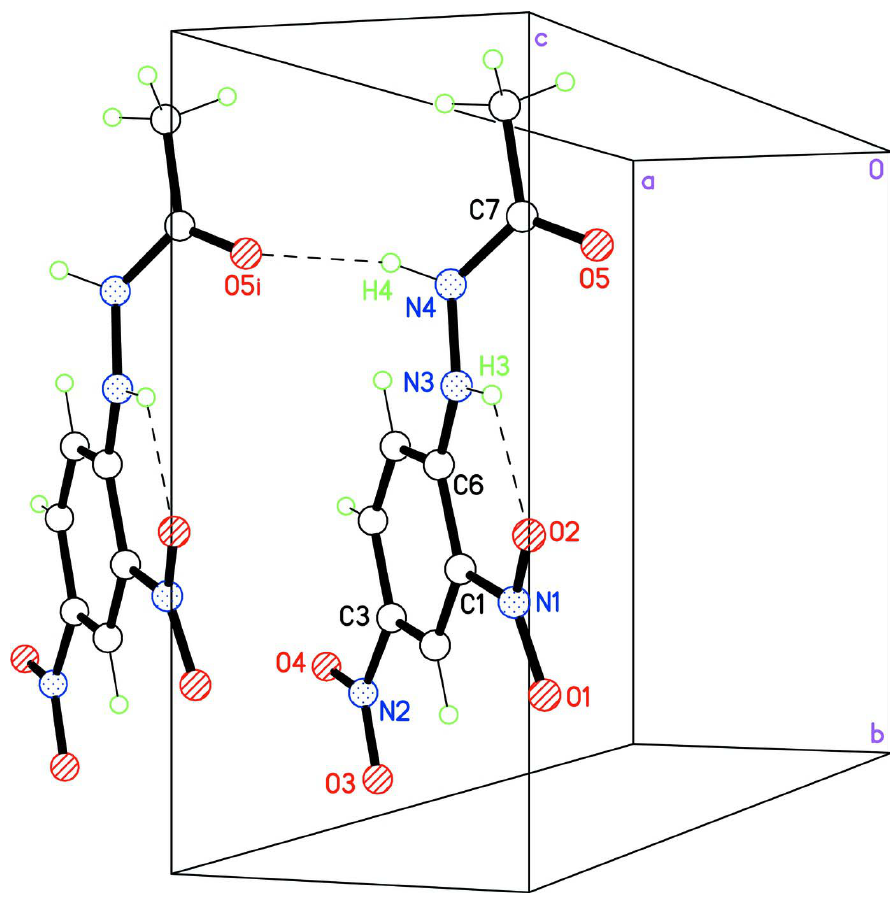
Figure 2 Perspective view of molecules linked via intermolecular N—H···O=C hydrogen bonds parallel to a